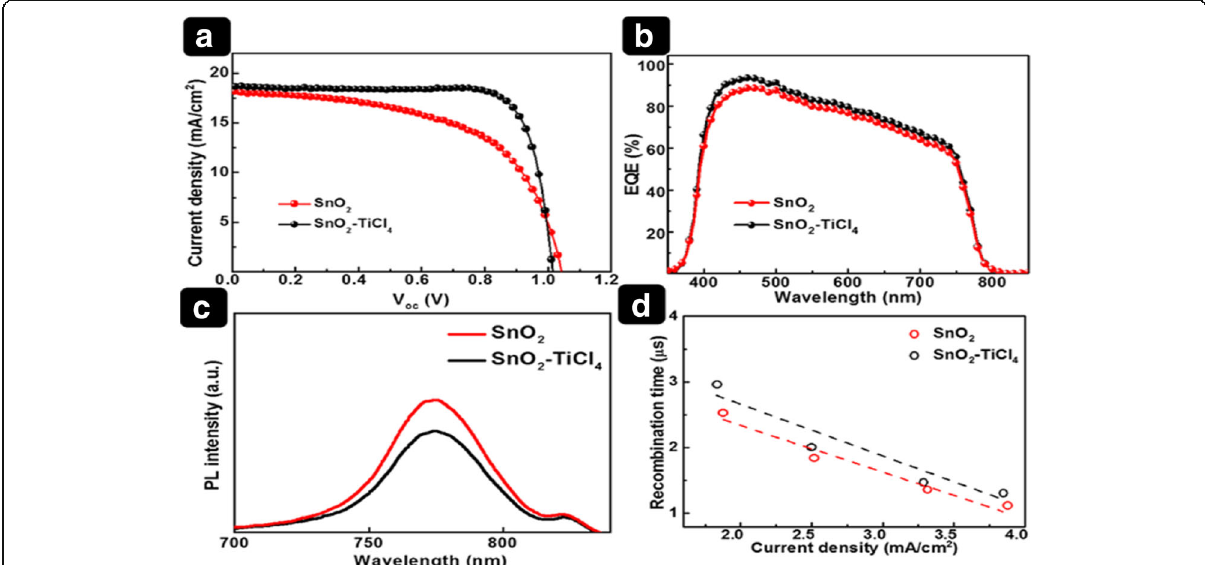
Fig. 6 Cell performance with IPCE and PL data. ( a ) J – V curves and ( b ) EQE spectra of PSC devices based on SnO 2 and SnO 2 – TiCl 4 . ( c ) Steady-state PL spectra of FTO/SnO 2 /perovskite and FTO/SnO 2 -TiCl 4 /perovskite samples. ( d ) Recombination time versus current